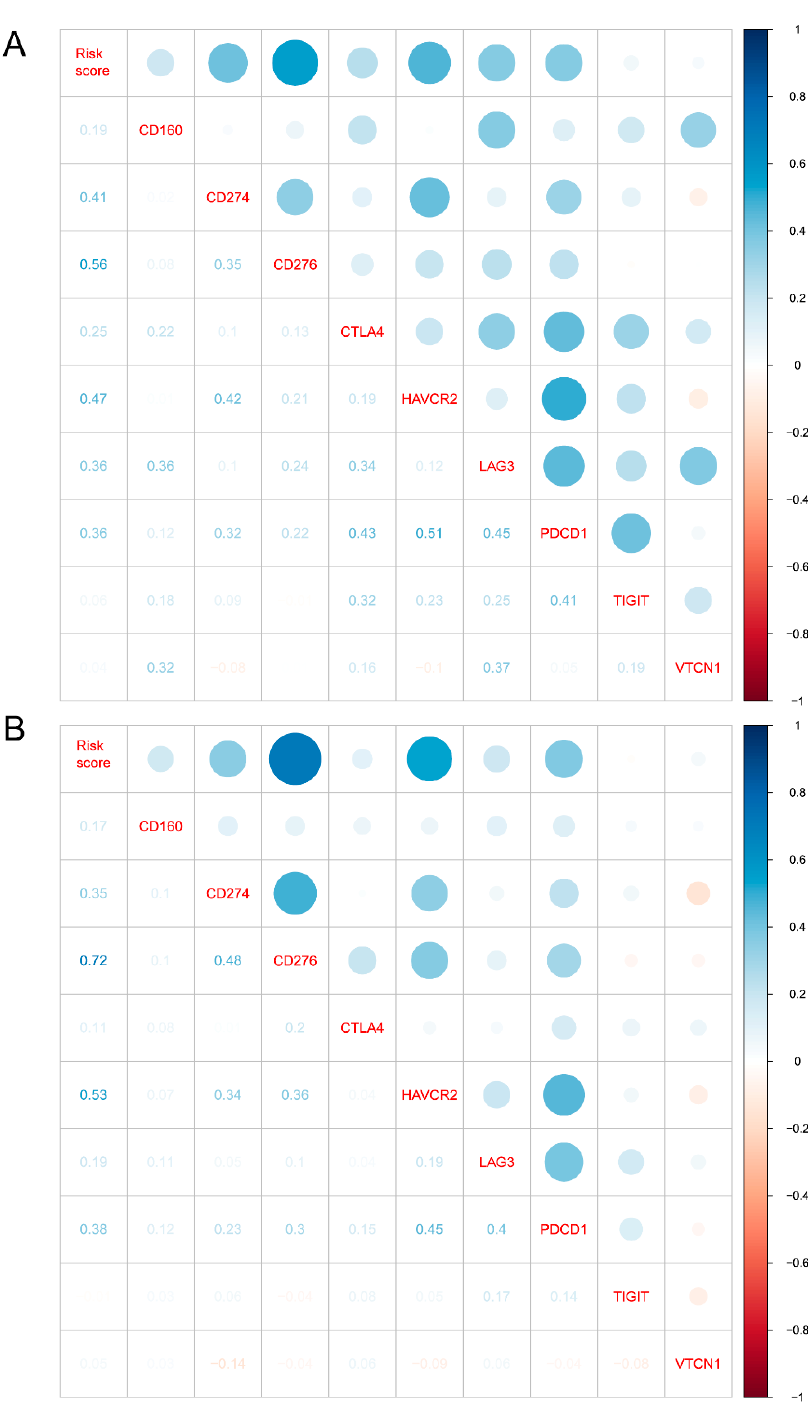
Figure 6. The 10-gene risk signature was strongly correlated with inhibited immune phenotype of gliomas. ( A ) Correlation analysis between risk score and immune suppressor in CGGA dataset. ( B ) Correlation analysis between risk score and immune suppressor in TCGA dataset.